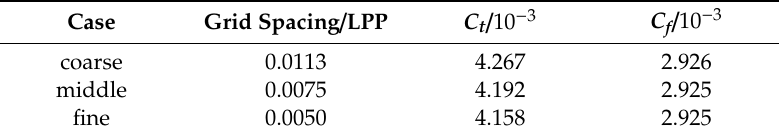
Table 11. The grid spacing convergence analysis.